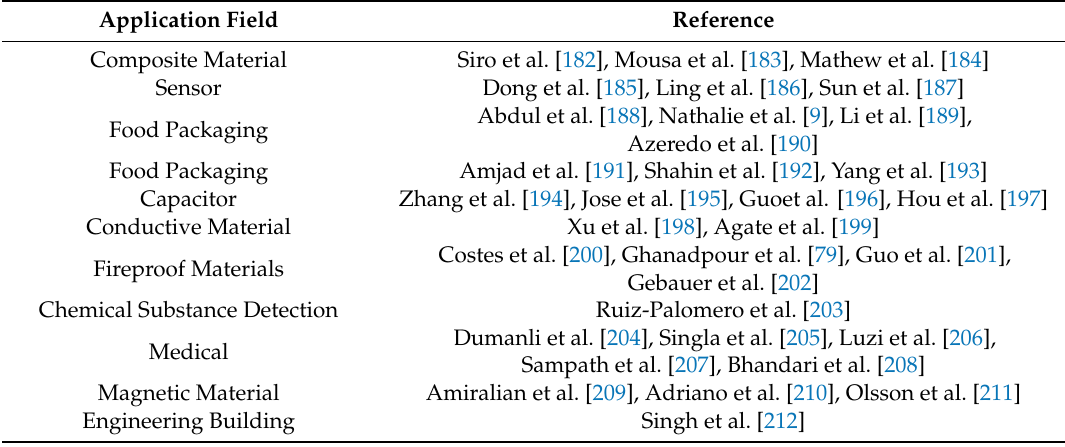
Table 4. Functional applications of nanocellulose and related